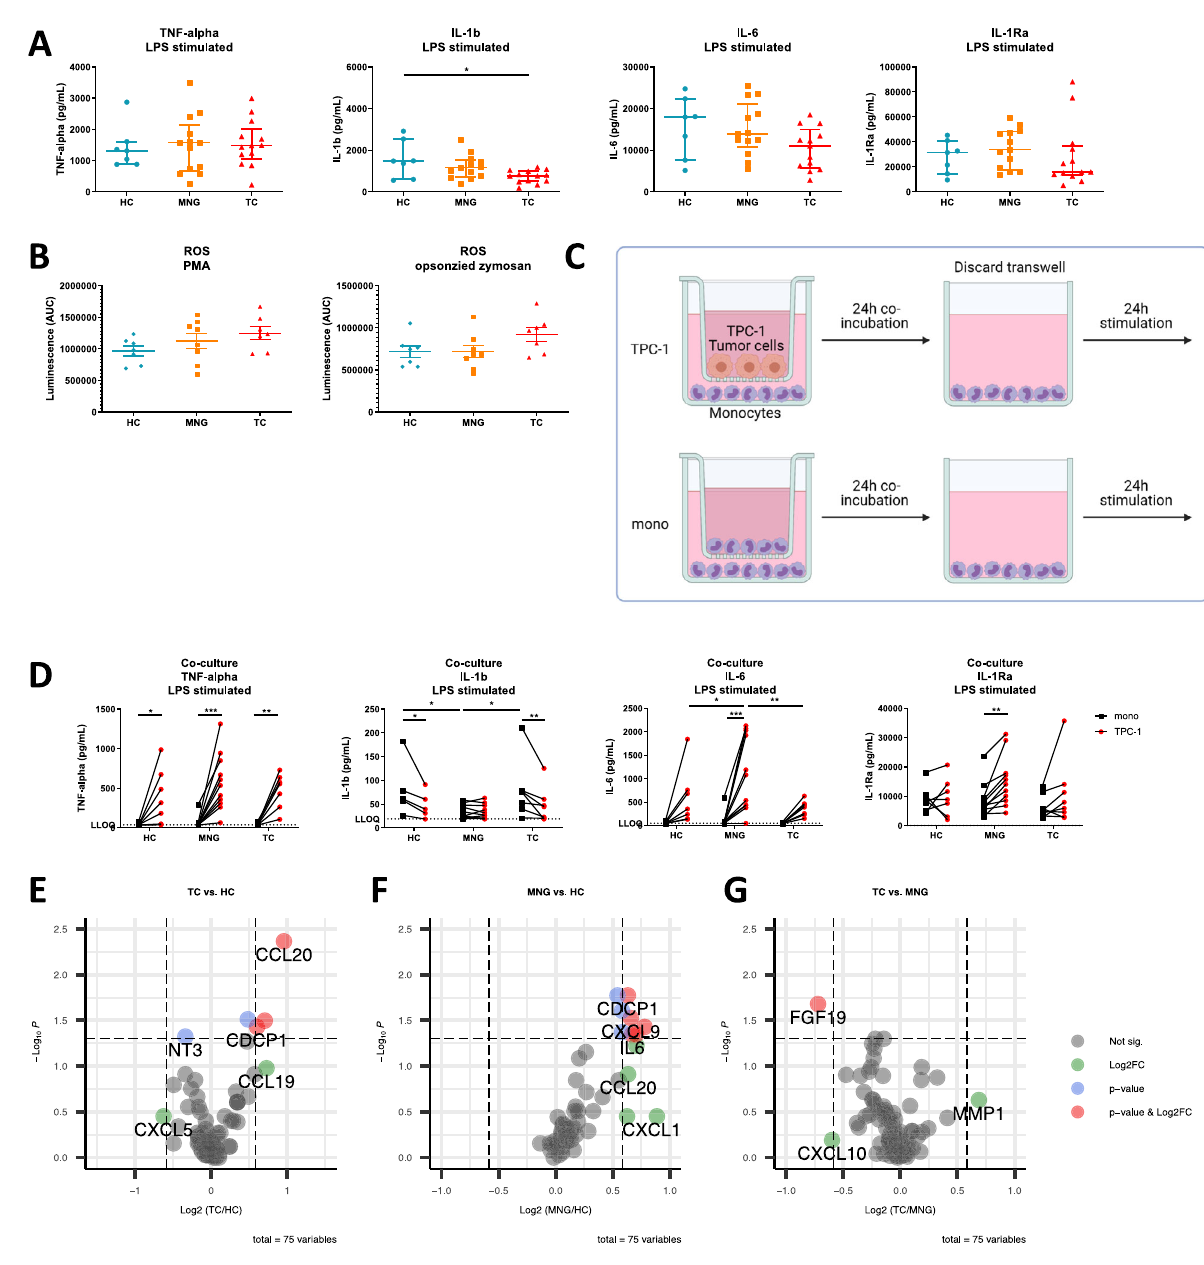
Fig. 3 | Functional phenotype of peripheral blood classical monocytes and circulating in fl ammatory markers. A Cytokine release of CD14 + CD16 - classical monocytes after 24h stimulation with TLR4 ligand LPS. (HC n =7, MNG n =13, TC n =13) Median with IQR. Corrected for age and sex. B ROS production of CD14 + CD16 - classicalmonocytes during 1h stimulation with PMA or opsonized zymosan. (HC n =7, MNG n =8, TC n =7) Mean±SEM. Corrected for age and sex. One-way ANOVA followed by Bonferroni correction. C Graphical illustration of co-culture experiment.CD14 + CD16 − classicalmonocyteswereindirectlyco-culturedwithTPC- 1 cells by using a transwell system. Monocytes in the transwell were used as a control condition. After 24h co-incubation the transwell with the tumor cells was discardedandthemonocyteswerestimulatedwithLPSfor24h.Illustrationcreated with BioRender.com. D Cytokine production of CD14 + CD16 − classical monocytes afterindirectco-culturewithTPC-1cellsfollowedby24hLPSstimulation.(HC n =7,